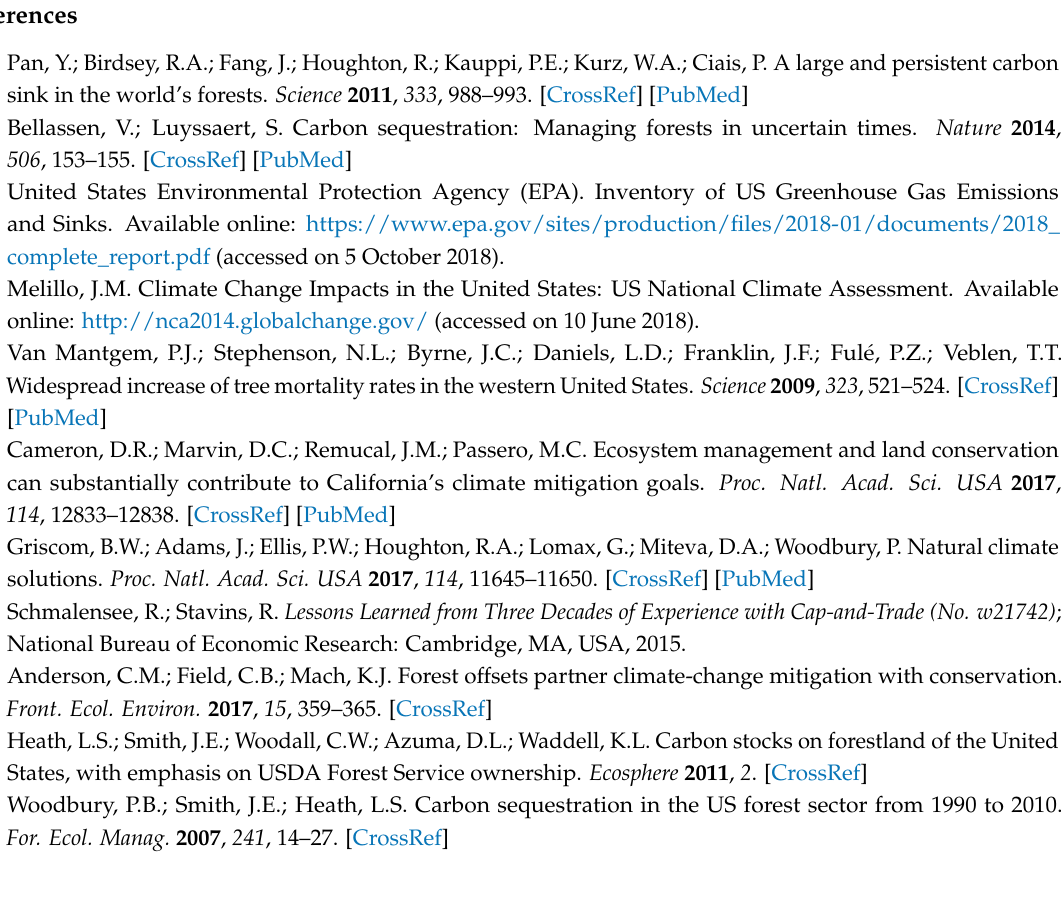
Table S1: Pinchot Institute Literature Review